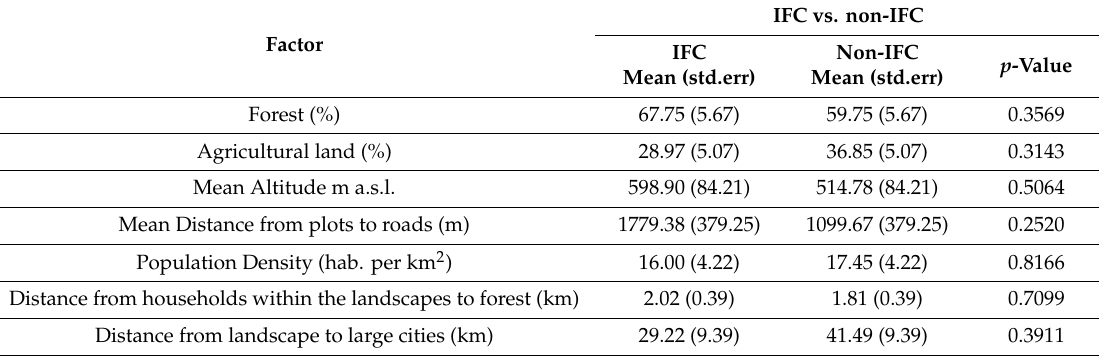
Table A3. Analysis of variance between IFC and Non-IFC landscapes considering cofounding variables.